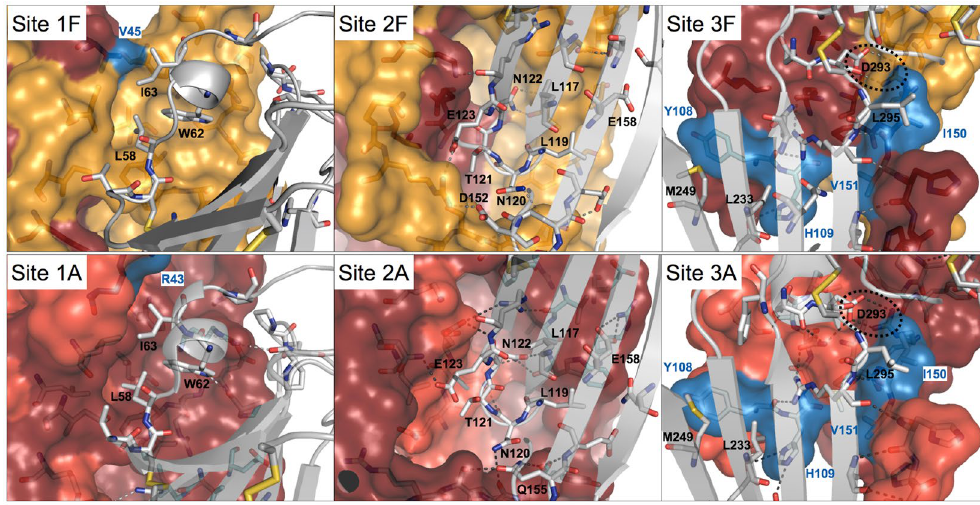
Figure 4. Conserved binding interactions and binding sites in IL-17A, IL17F and IL-17A/F. Top row: IL- 17A/F complex with IL-17RA. Sites 1F-3F of IL-17A/F are depicted as surface representations, with the A- and F-subunits in carmine and orange, respectively. Non-conserved side-chains with respect to the IL-17F homodimer are in blue. The IL-17RA receptor is shown as a grey ribbon with key side-chains depicted in stick representation. Bottom row : IL-17A complex with IL-17RA (4hsa.pdb). Sites 1–3 of IL-17A are shown in surface representation with the 2 subunits in carmine and light red, respectively. Non-conserved side-chains in Sites 1A-3A of IL-17A/F are highlighted in blue. As before, the IL-17RA receptor is shown as a grey ribbon with key side-chains depicted in stick representation. Note the conservation of Site 1A-2A of IL-17A/F with respect to